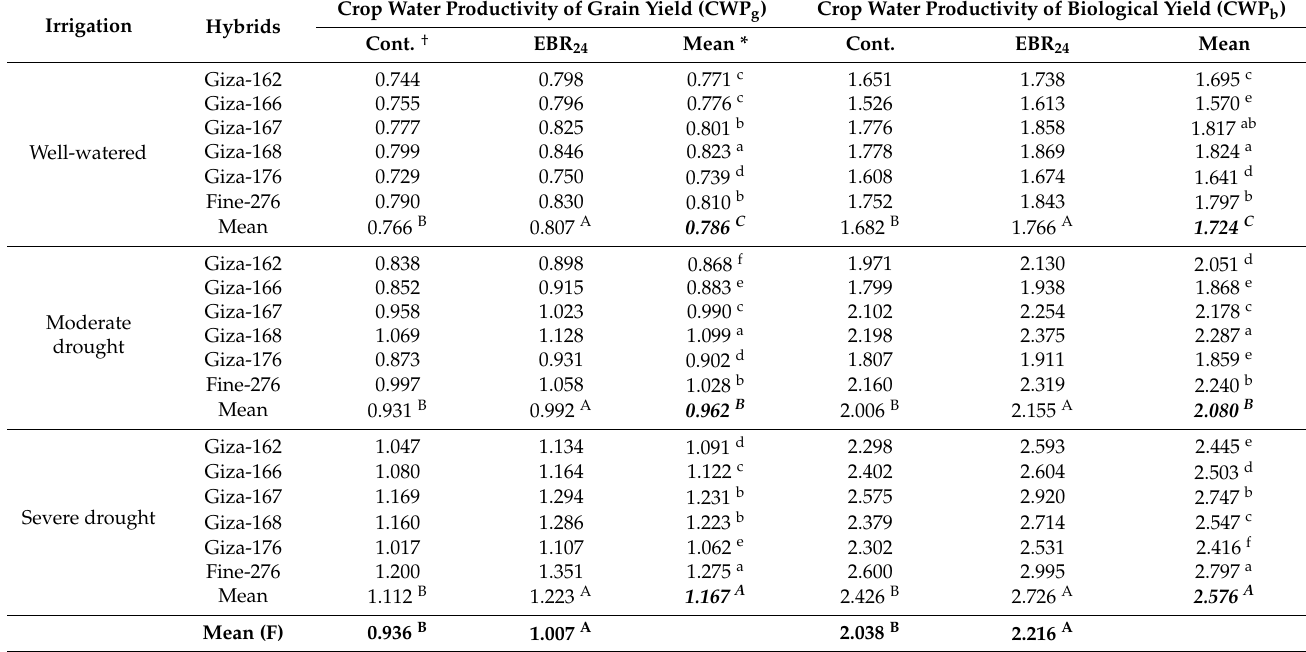
Table 6. Impact of 24-epibrassinolide (EBR 24 ) application on the crop water productivity of grain yield (CWP g , kg m − 3 ) and biological yield (CWP b , kg m − 3 ) of six maize hybrids grown under three irrigation regimes over the two growing seasons of 2018 and